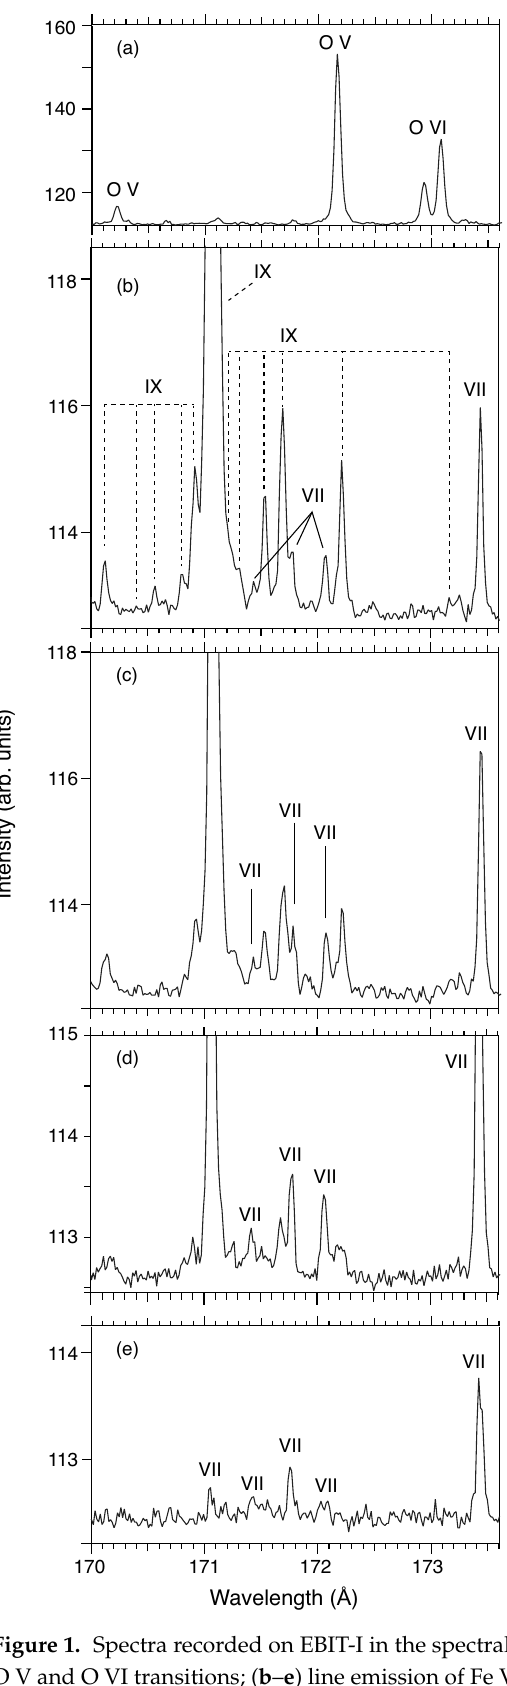
Figure 1. Spectra recorded on EBIT-I in the spectral range 170.0 to 173.6 Å: ( a ) Line emission from O V and O VI transitions; ( b – e ) line emission of Fe VII – Fe IX recorded at a nominal electron beam energy of ( b ) E beam = 170 eV, ( c ) E beam = 130 eV, ( d ) E beam = 110 eV, and ( e ) E beam = 90